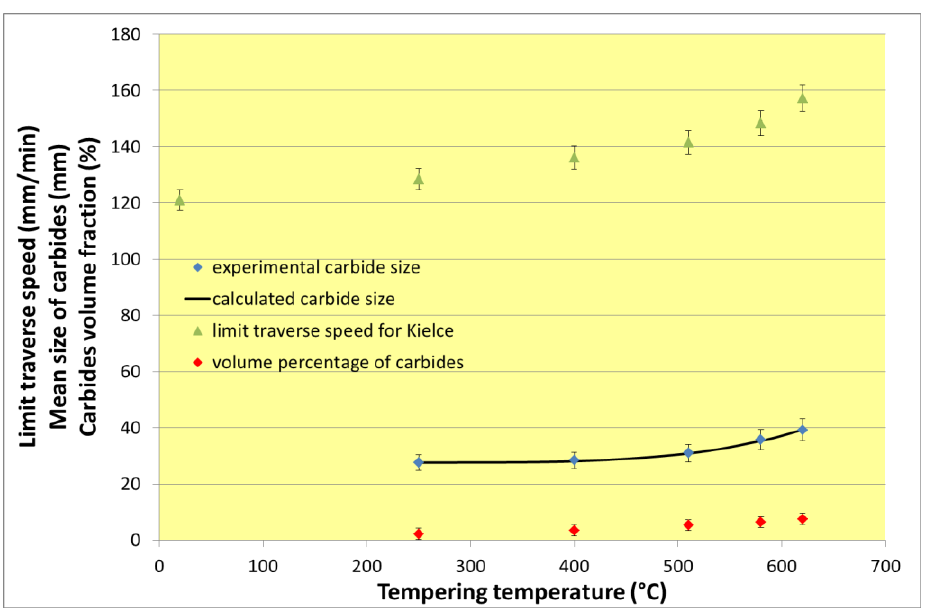
Figure 9. Trends of dependences of the carbide sizes, volume percentage of carbides and the limit traverse speeds on the tempering temperatures of samples used for research of material structure influence on AWJ cutting forces (the uncertainty magnitudes of experimental and calculated values are added).